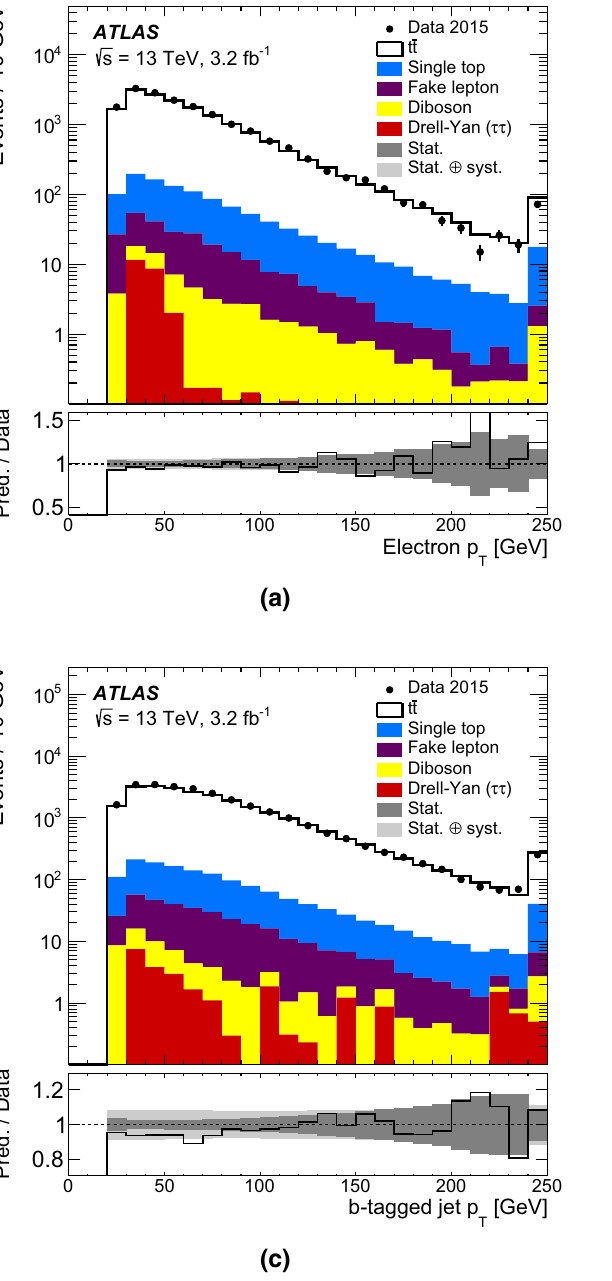
simulation with a lifetime longer than 3 × 10 − 11 s (stable) in the generator-level information are used. Particle-level elec- trons and muons are identified as those originating from a W -boson decay, including those via intermediate τ